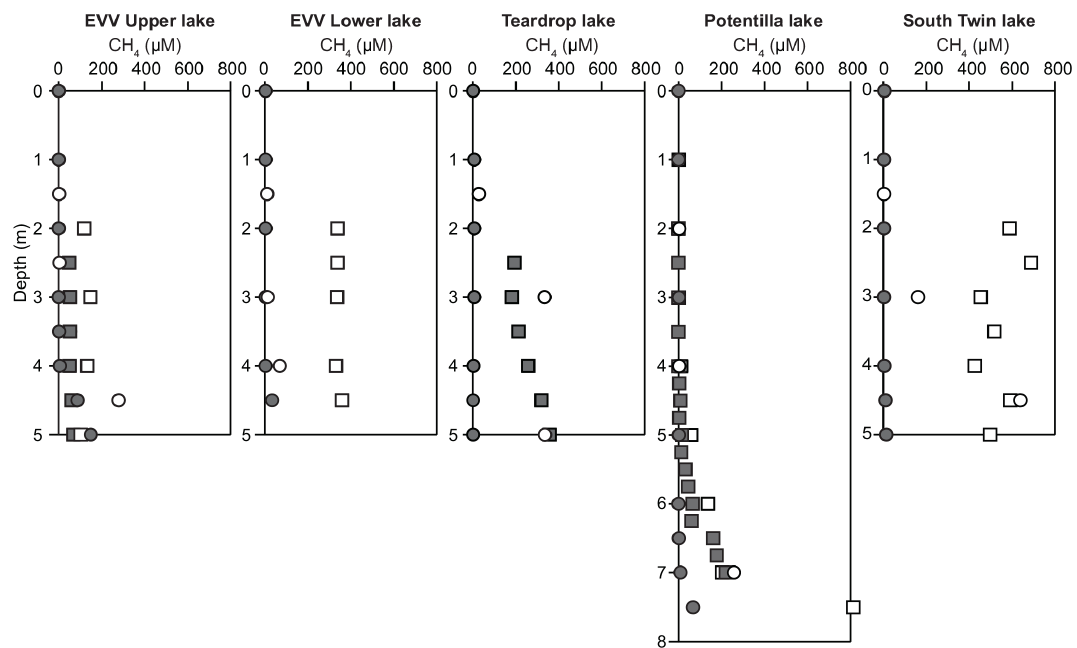
Figure 7. Profiles of dissolved CH 4 under open-water conditions (circles) in July 2012 (open) and July 2013 (closed) and ice-covered conditions (squares) in April 2013 (open) and April 2014 (closed). Concentrations of CH 4 under open-water conditions in 2013 and ice- covered conditions in 2014 can also be seen in Cadieux et al.